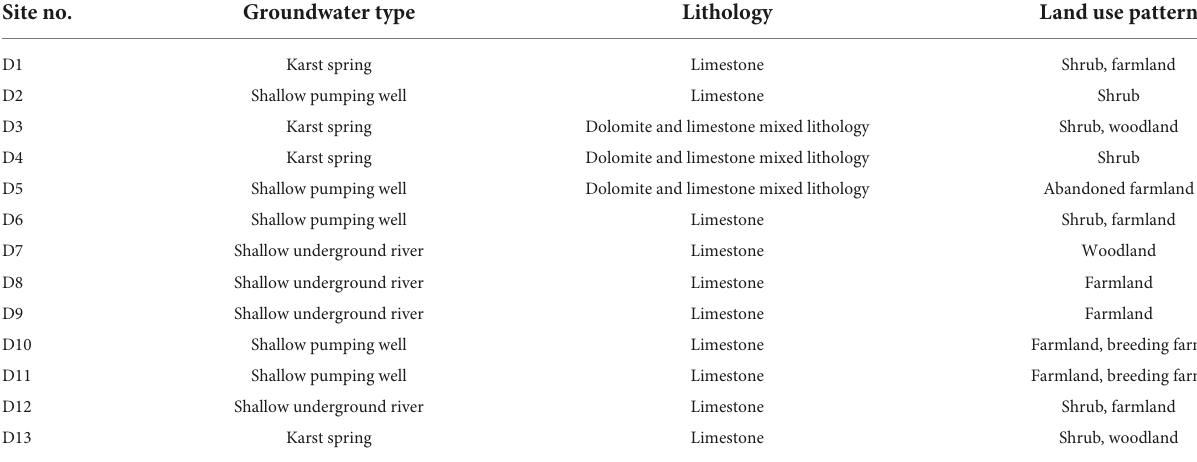
TABLE 1 Hydrogeological information and land use patterns at various sampling sites in the Huixian karst groundwaters, China. Site